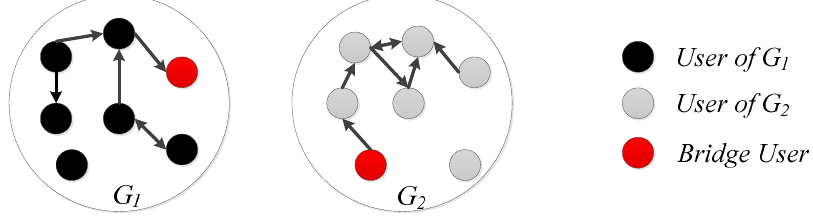
Figure 2. Information spread within a single social network.